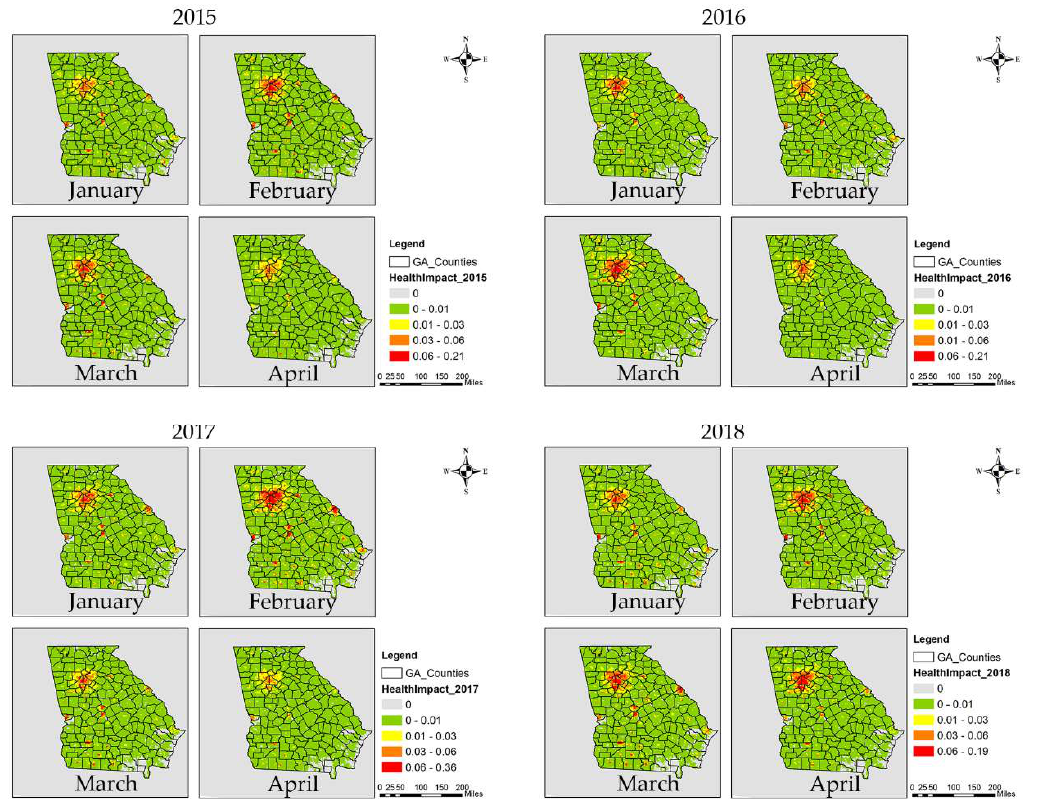
Figure 5. Estimated total monthly asthma-related ER visits (health impact) due to prescribed fires from 2015 to 2018, first four months.